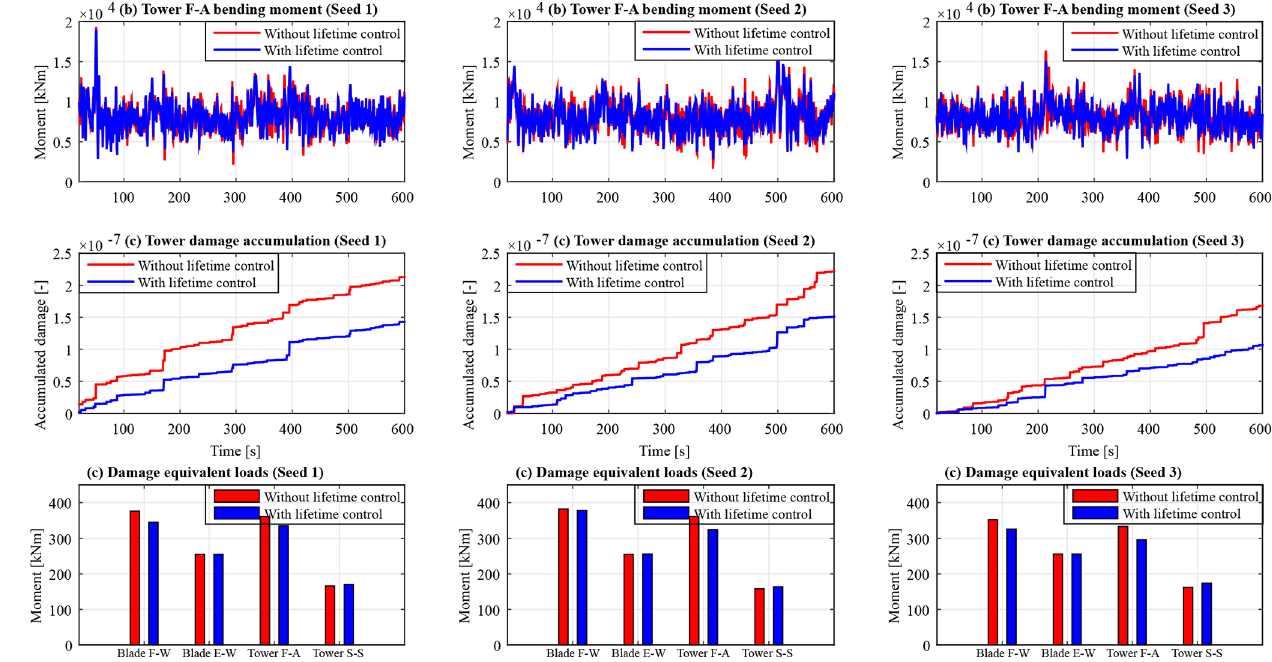
Figure 8. Tower fatigue load mitigation and DEL analysis for 18ms − 1 wind.